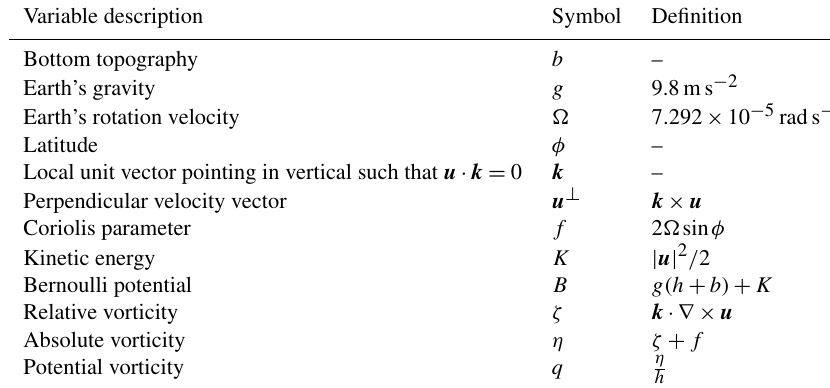
Table 2. Variables and parameters for the shallow-water model.